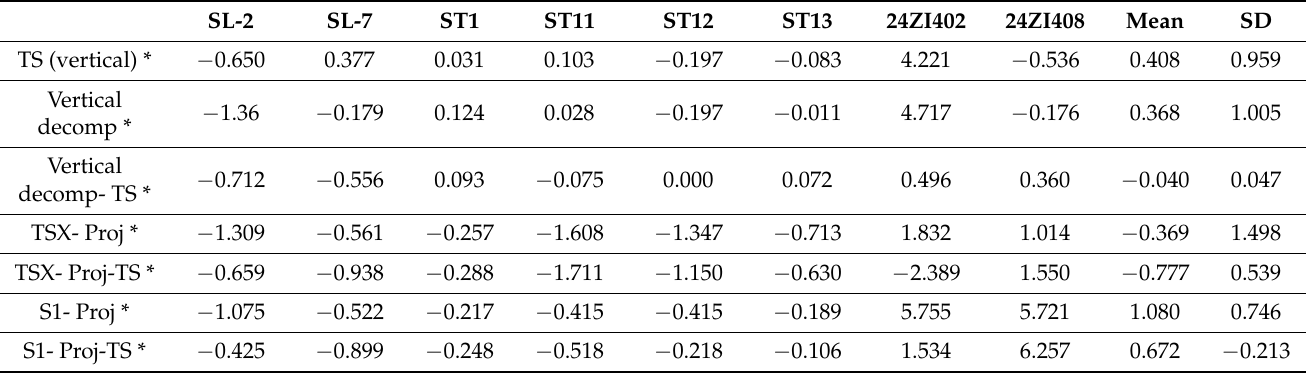
Table 3. Comparison of values of vertical